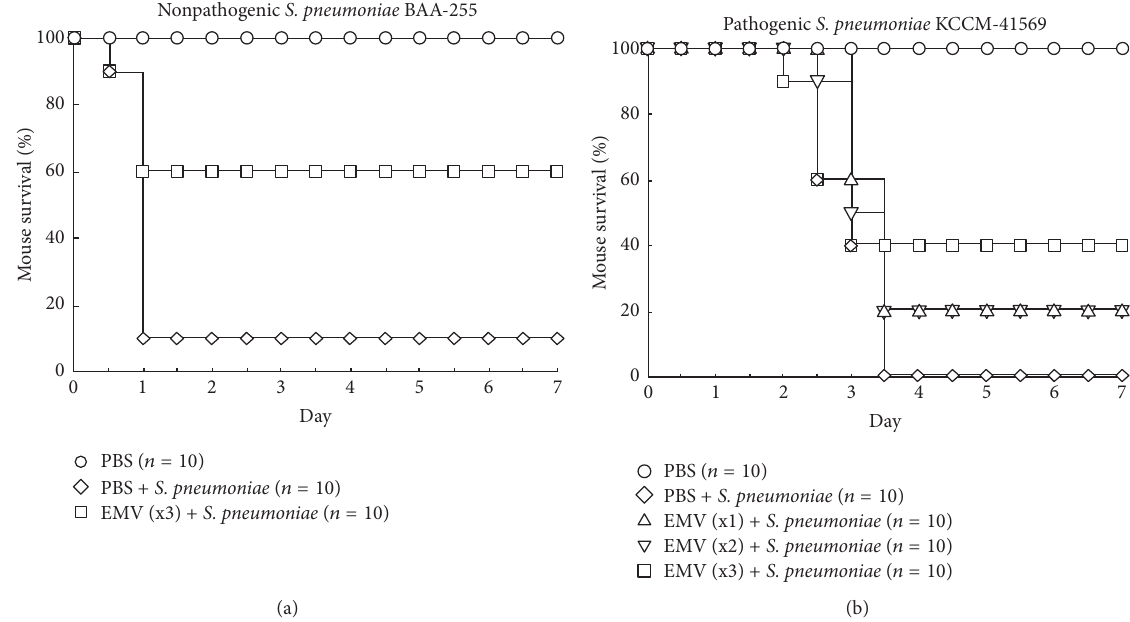
Figure3:Survivalofvaccinatedmiceafterinfectionwith Streptococcuspneumoniae .Mice(8weeksold)werevaccinatedintraperitoneallywith S. pneumoniae BAA-255 extracellular membrane vesicles. After intraperitoneal inoculation with 1 × 10 8 cfu of nonpathogenic S. pneumoniae BAA-255 or 1 × 10 3 cfu of pathogenic S. pneumoniae KCCM-41569, survival over 7 days was assessed. Equivalent volumes of phosphate- buffered saline served as a vaccine control.